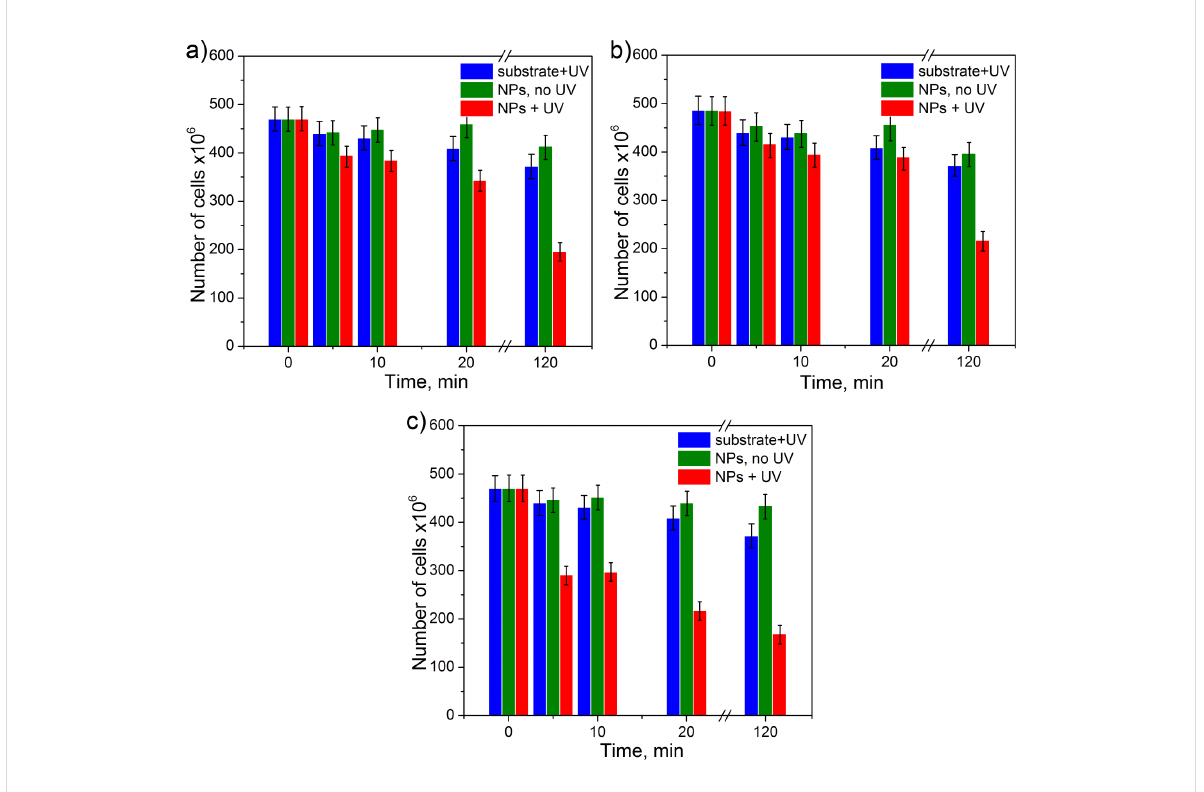
Figure 5: Evolution of cell number with time on the samples of (a) type 1, (b) type 2 and (c) type 3 without and with UV illumination. Zero time corre- sponds to the initial number of bacteria incubated on the samples. Efficiency in destroying the bacteria by UV light on substrates without particles is also shown for comparison. Vertical bars illustrate typical uncertainty in the bacteria